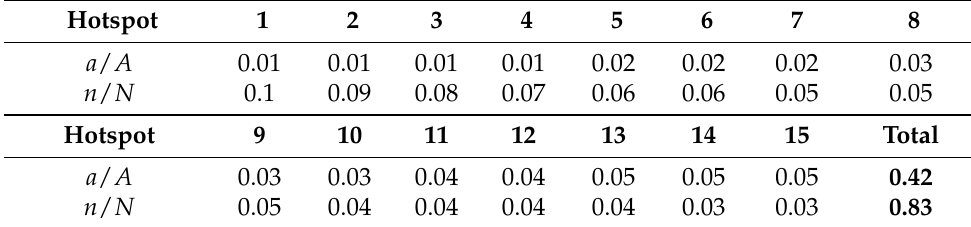
Table 1. Hotspots, their relative area ( n / N ) and hit rate ( a / A ) for the hypothetical example.